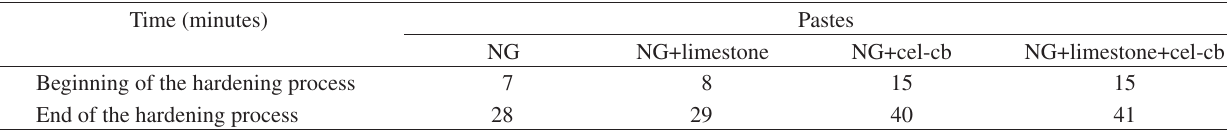
Table 5. Hydration time of the pastes with and without cellulose pulp, and with and without limestone powder. Time